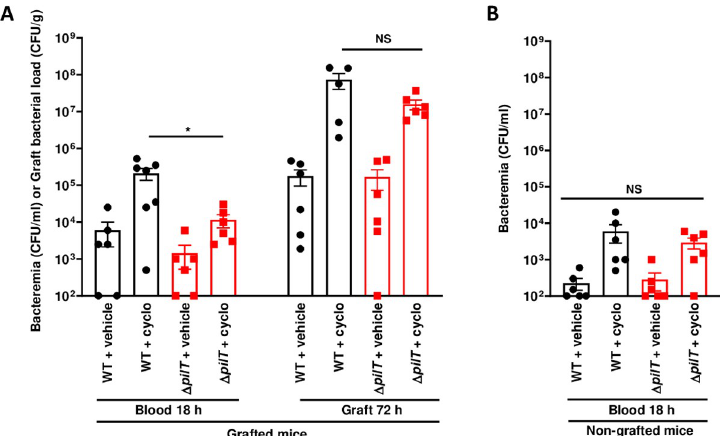
Fig 5. Monocytes and neutrophils actively control the bacteremia induced by WT or Δ pilT strains. (A) Grafted and (B) non-grafted SCID mice treated with cyclophosphamide (cyclo) and infected with 5x10 3 CFU of WT N . meningitidis or Δ pilT mutant. Bacteremia was assessed at 18 h post-infection by blood puncture. Mice were sacrificed at 72 h post-infection and graft bacterial load was measured by quantitative culture. Two independent experiments, with n = 6 mice in each group. Bars represent mean ± SEM. NS p > 0.05; � p < 0.05, one-way ANOVA followed by multiple comparison test.